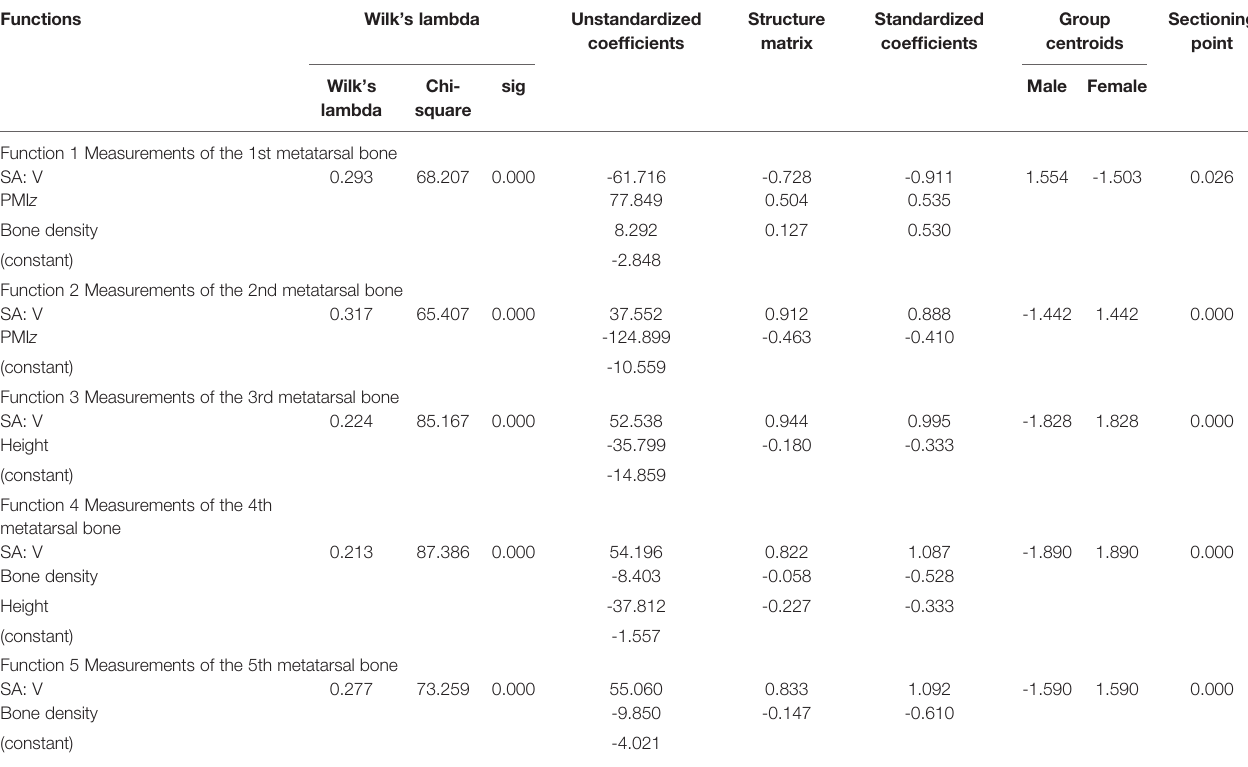
TABLE 8B | Stepwise discriminant function analysis for right metatarsal bone.